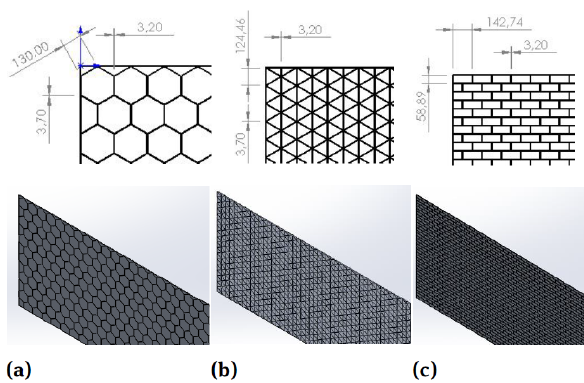
Figure 5: Geometrical models of the modified container panel: (a) general honeycomb, (b) cross honeycomb, and (c) square honey- comb